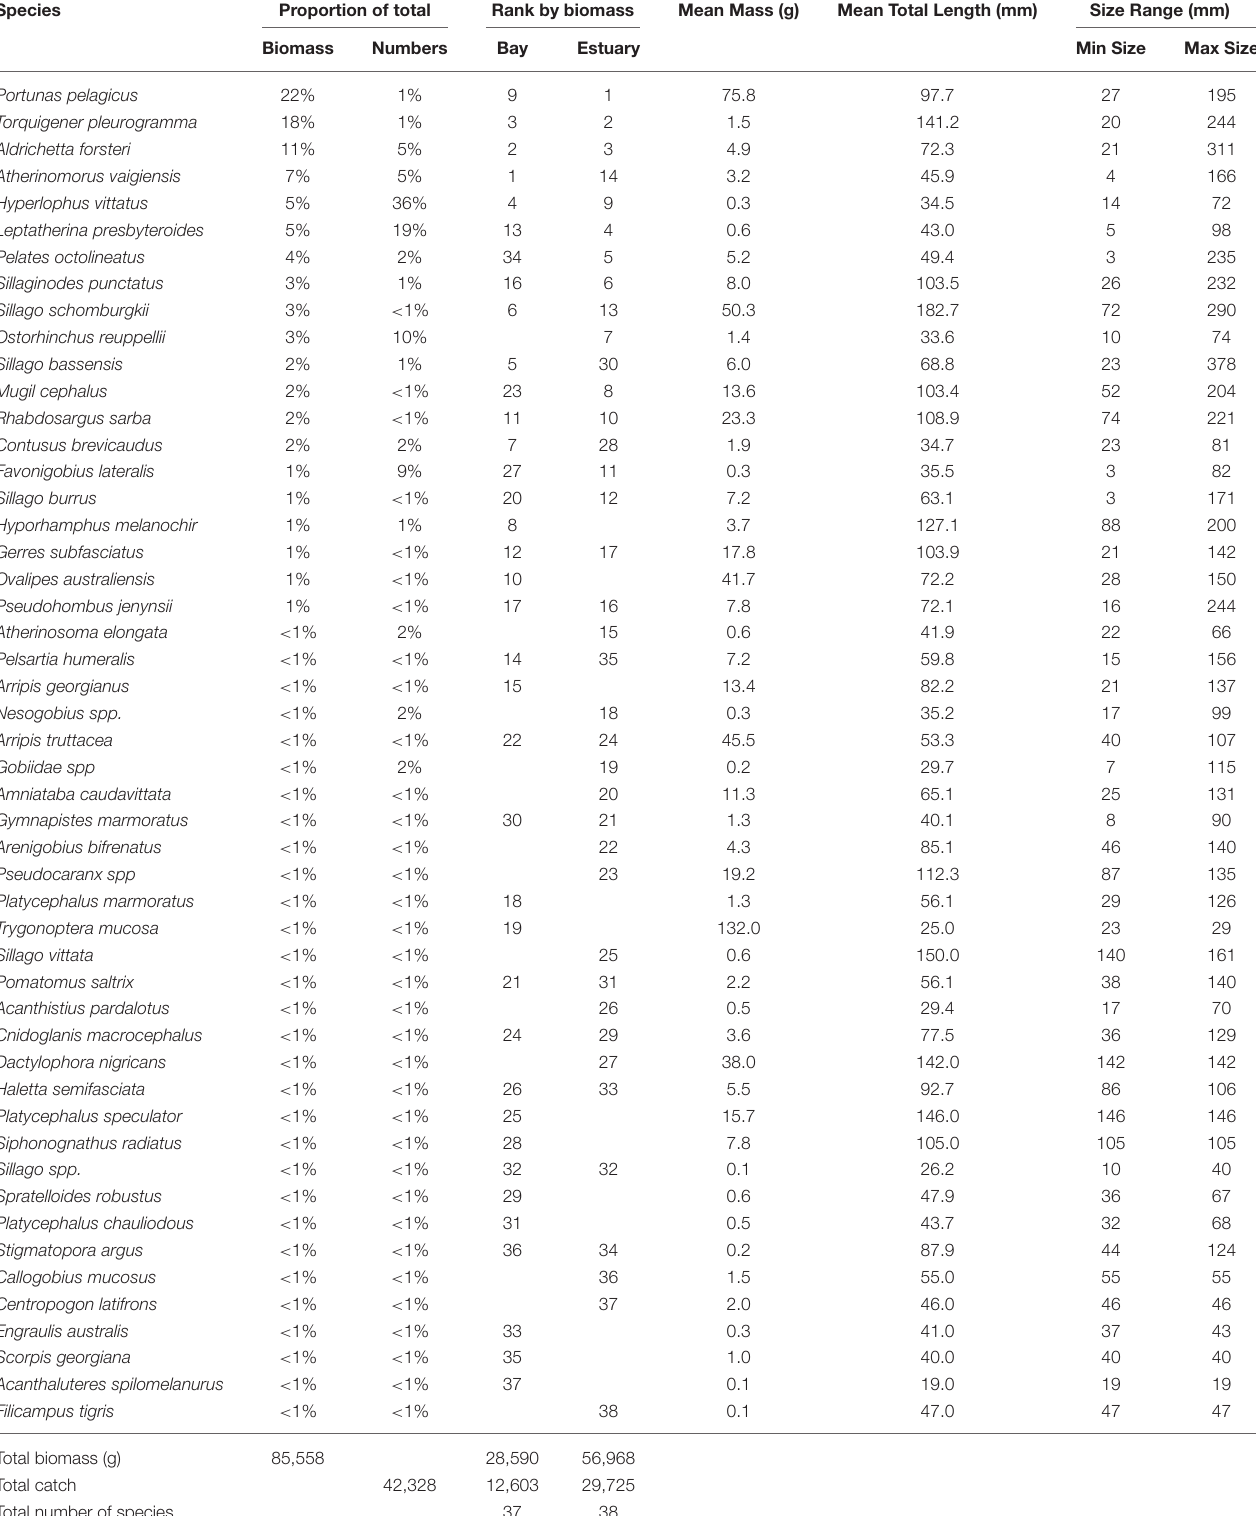
TABLE 5 | Proportion contribution of each species to the total catch in seine nets by biomass (g) and numbers, and the rank by biomass in the Bay, and Estuary.